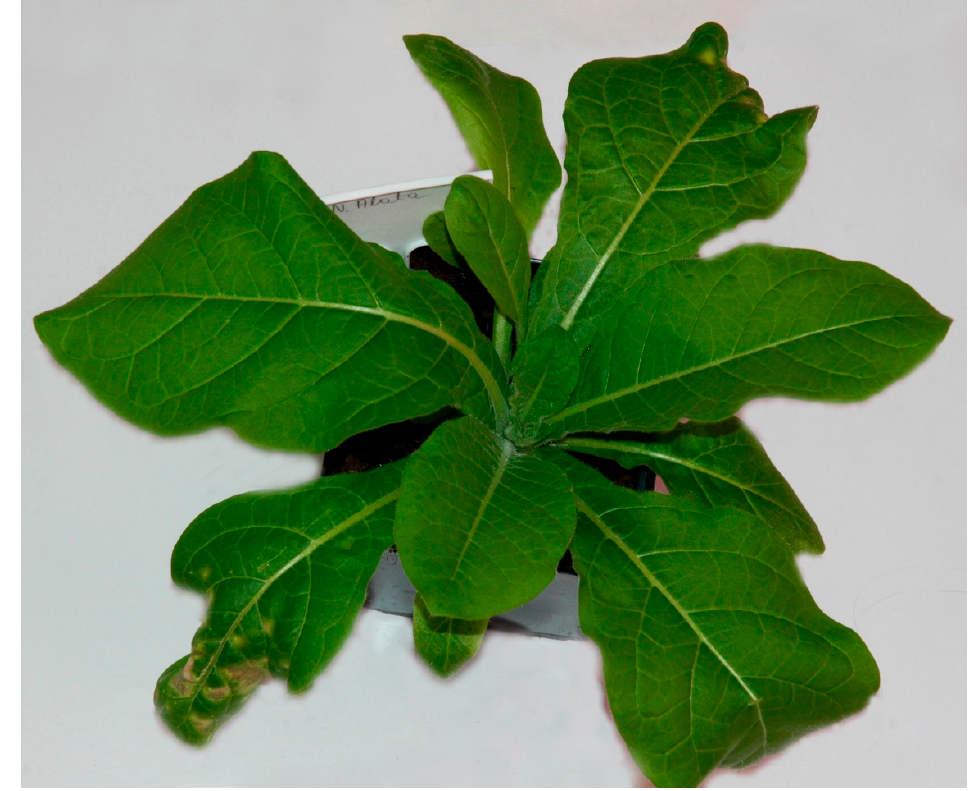
Figure 4. Hypersensitive symptoms shown as necrotic spots on lower leaves of N. alata four weeks after inoculation with TSWV.